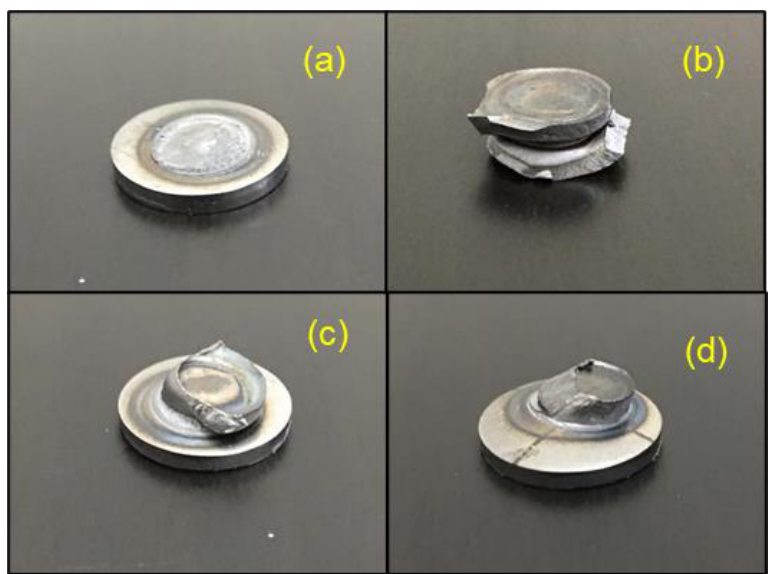
Figure 13. Typical failure modes observed after low dynamic TS testing. ( a ) Interfacial failure (IF) mode, ( b ) pullout failure (PF) mode, ( c ) partial interfacial failure (PIF) mode and ( d ) partial thickness–partial pullout (PTPP) mode.